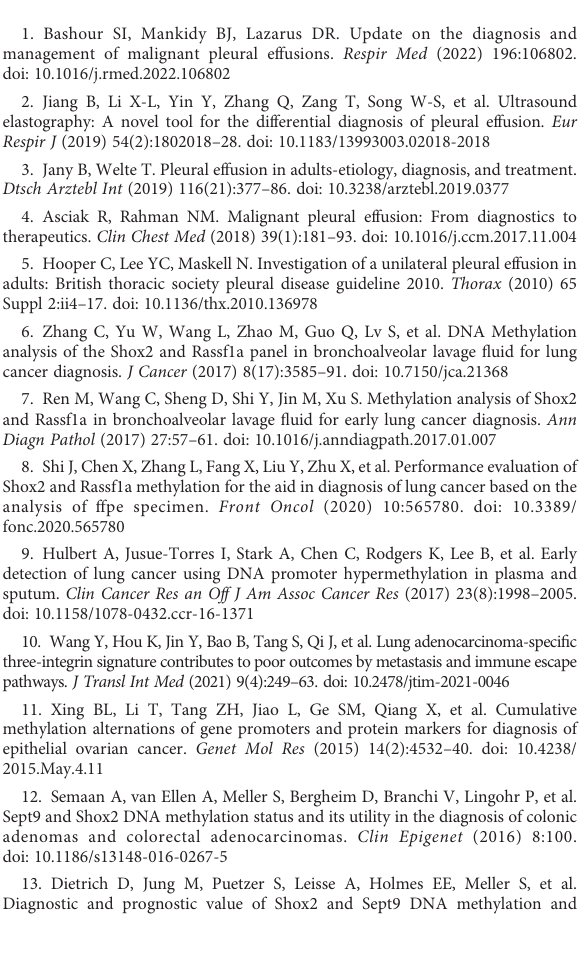
analyzing 6 different relative SHOX2 concentration (0.4%, 0.8%, 1.6%, 6.4%, 25%,100%) with a total DNA concentration indicated by CtIC (20:2500copies/ul); (D) Ampli fi cation curve of SEPTIN9 was evaluated by analyzing 6 different relative SEPTIN9 concentration (0.4%, 0.8%, 1.6%, 6.4%, 25%,100%) with a total DNA concentration indicated by CtIC (20:2500copies/ul); fi ve PCR replicates pre sample were performed. SUPPLEMENTARY FIGURE 3 ROC curves for the LungMe methylation panels in older patients ( ≥ 50 years old) (A) , and in young individuals (between 25 and 50 years old) (B). ROC curves for the OncoMe methylation panels in older patients ( ≥ 50 years old) (C) , and in young individuals (between 25 and 50 years old)